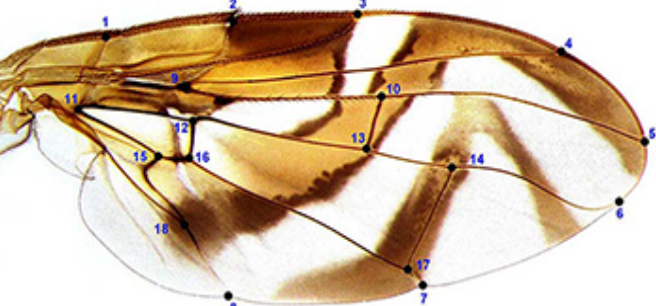
Figure 2. Female wing of a specimen of the AF complex. Right wing showing the 18 landmarks used for the geometric morphometric analysis.